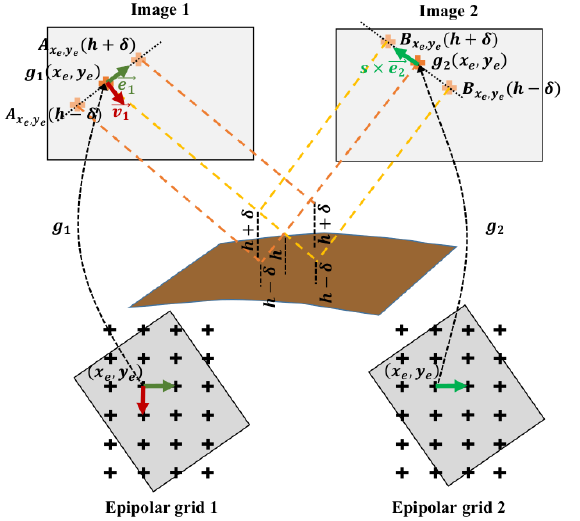
Figure 2. Epipolar grids are constructed iteratively by moving along local epipolar curves